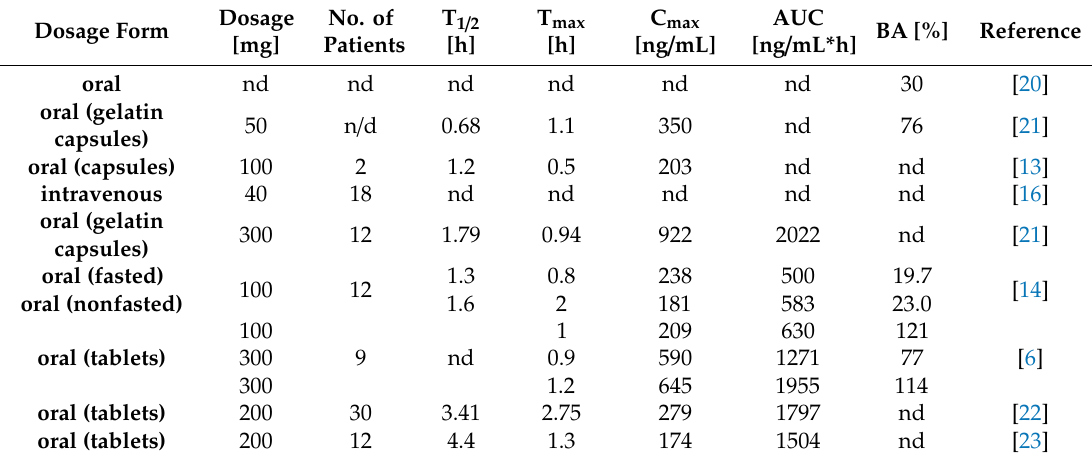
Table 1. Summary of literature data on the NF